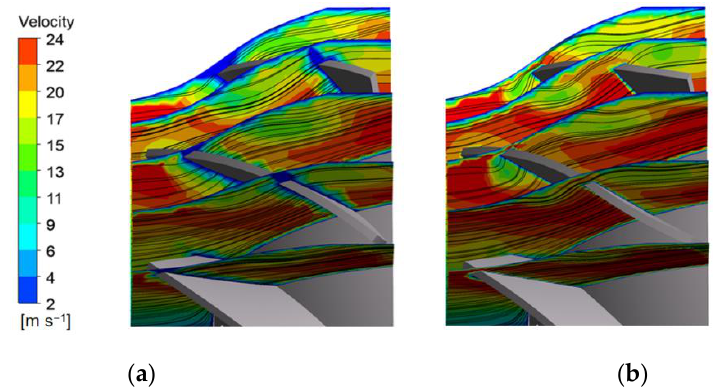
Figure 15. Flow chart of impeller region. ( a ) Original. ( b ) Optimized.